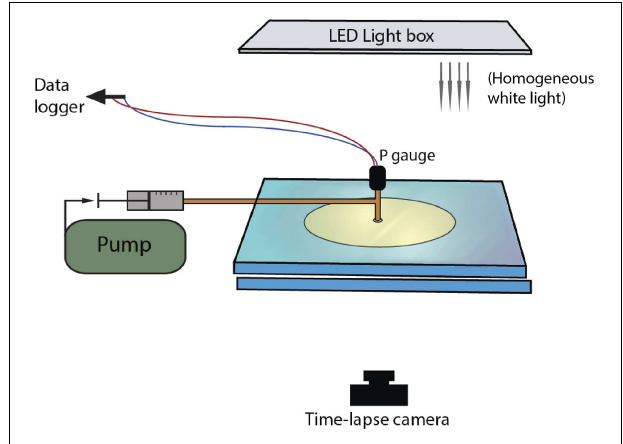
FIGURE 1 | Experimental set-up for injection of single bubbles into particle suspensions sandwiched between parallel